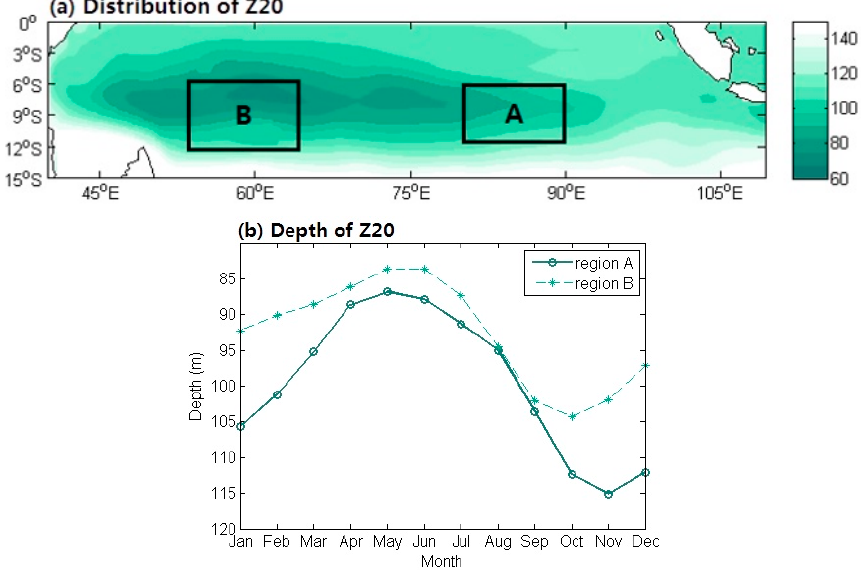
Figure 9. ( a ) Annual mean depth (m) of Z20; and ( b ) monthly Z20 averaged in Regions A and B as a function of calendar month during 1982 – 2010.